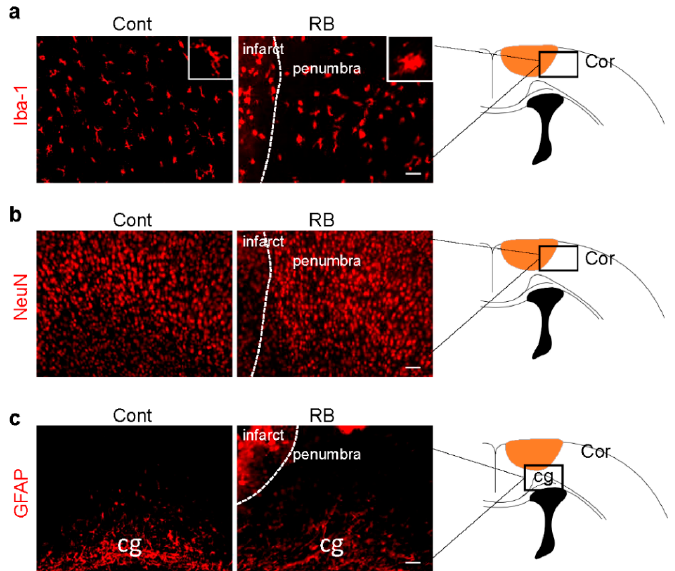
Figure 2. Microglia activation increased in the RB photothrombotic stroke but not in astrocytes and neurons. ( a ) Brain tissues were immunostained with anti-Iba-1 (microglial marker), ( b ) GFAP (astrocytic marker), and ( c ) NeuN (neuronal marker) antibodies. The white box shows microglia morphology under higher magnification. Scale bar = 100 µm. Abbreviations: Cont: control, Cor: cortex, cg: cingulated gyrus, Iba-1: isonized calcium-binding adaptor molecule 1, GFAP: glial fibrillary acidic protein, NeuN: neuronal nueclei